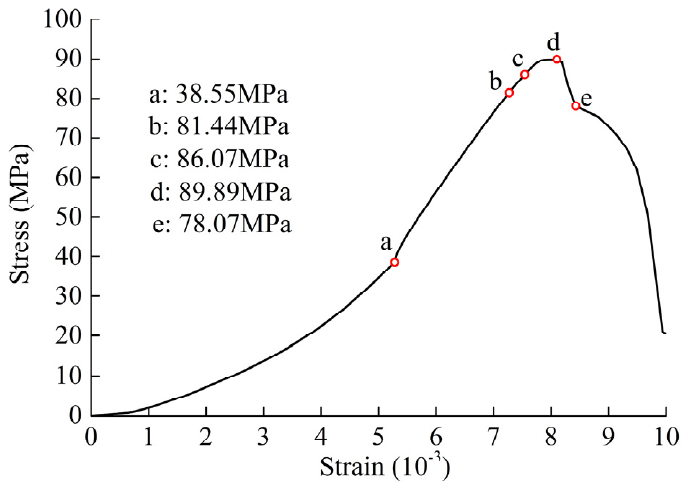
Figure 15. The stress–strain curve and five key stress points of specimen D10.